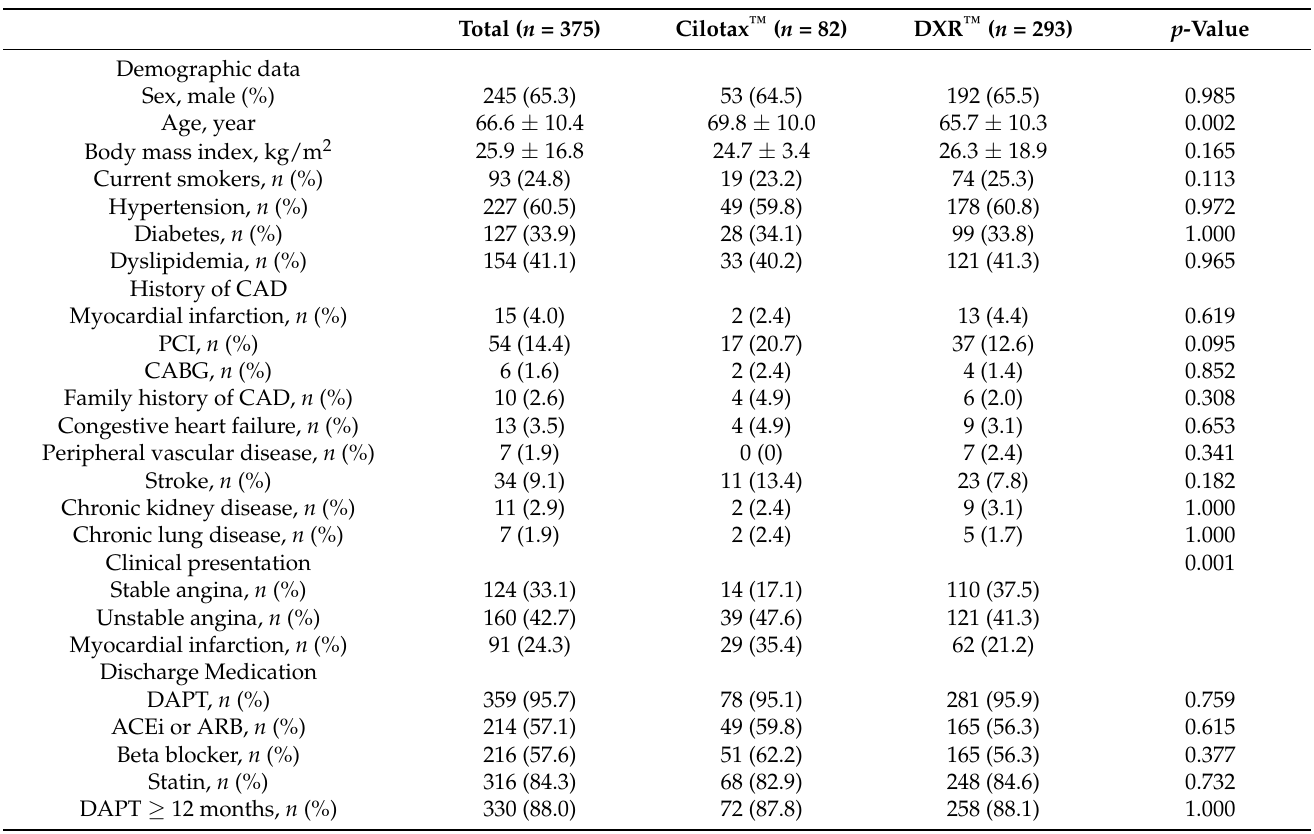
Table 1. Patients’ baseline characteristics.